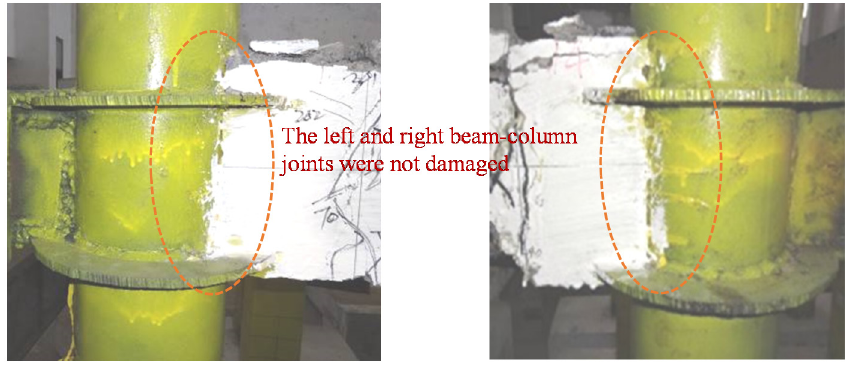
Figure 8. The core area of the joint.